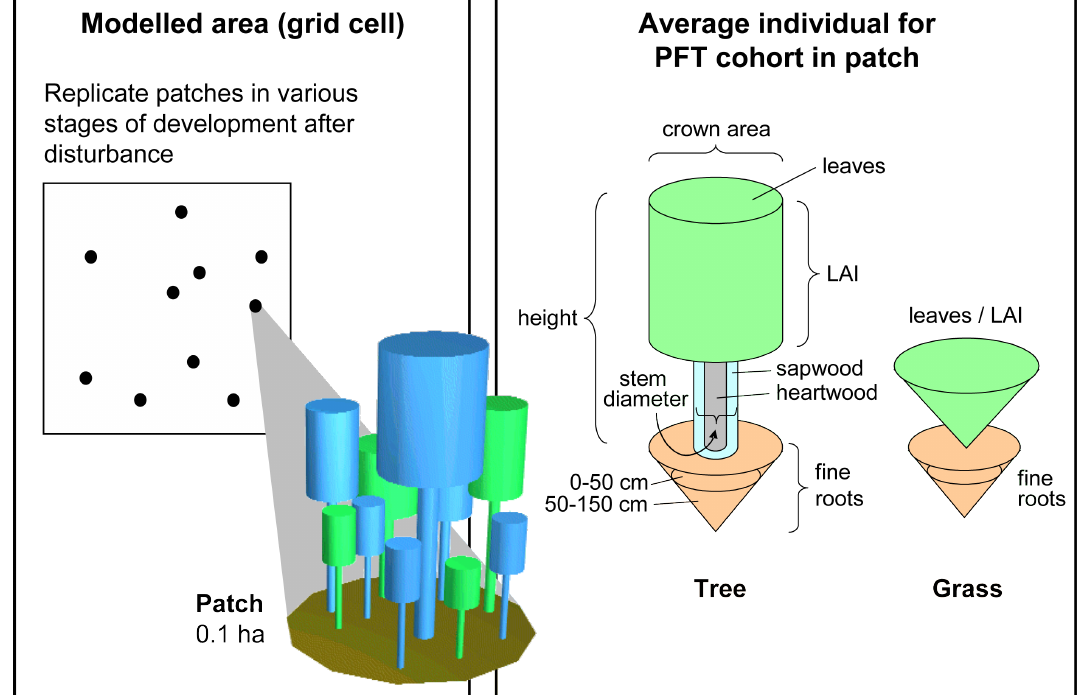
Fig. B1. Vegetation representation in LPJ-GUESS cohort